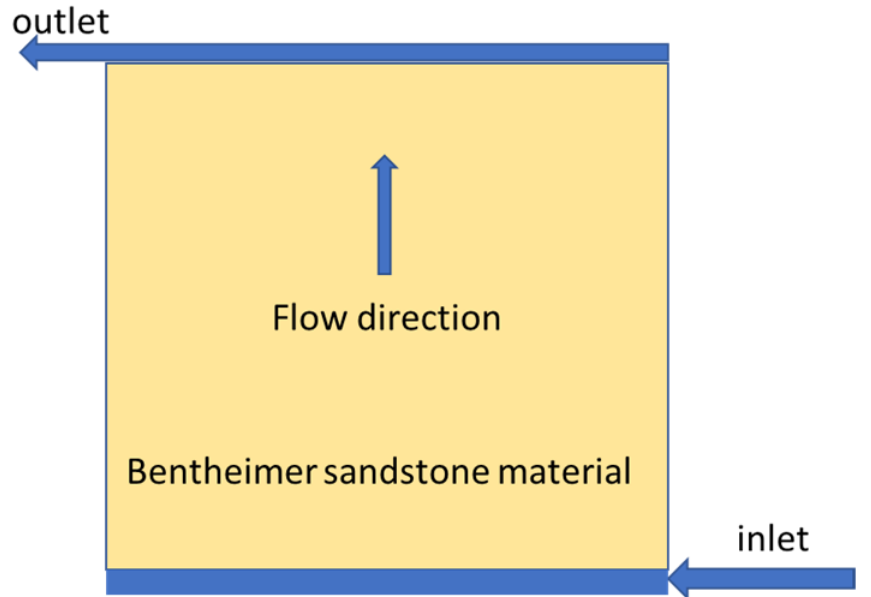
Figure 1. Tubing placement for horizontal inlet and outlet. The differential pressure is measured between inlet and outlet lines.